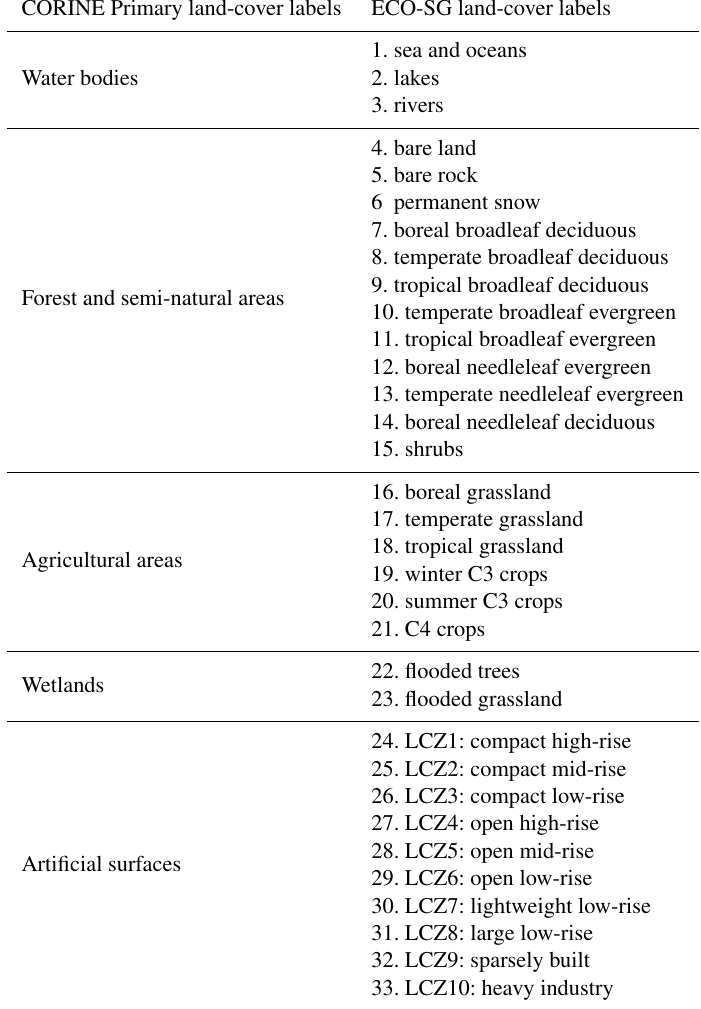
Table A1. Conversion table for ECO-SG labels to primary CORINE